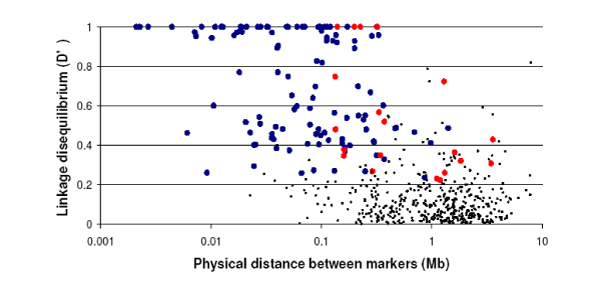
Standardized linkage disequilibrium as a function of intermarker distance. Standardized linkage disequilibrium (D') between markers of the X chromosome as a function of the intermarker distance. Large symbols: D' values with nominal p ≤ 0.01 (blue: adjacent markers; red: LD computed at 5-marker intervals). Dots: D' values with p > 0.01. Marker pairs with distance <1 kb have been omitted.